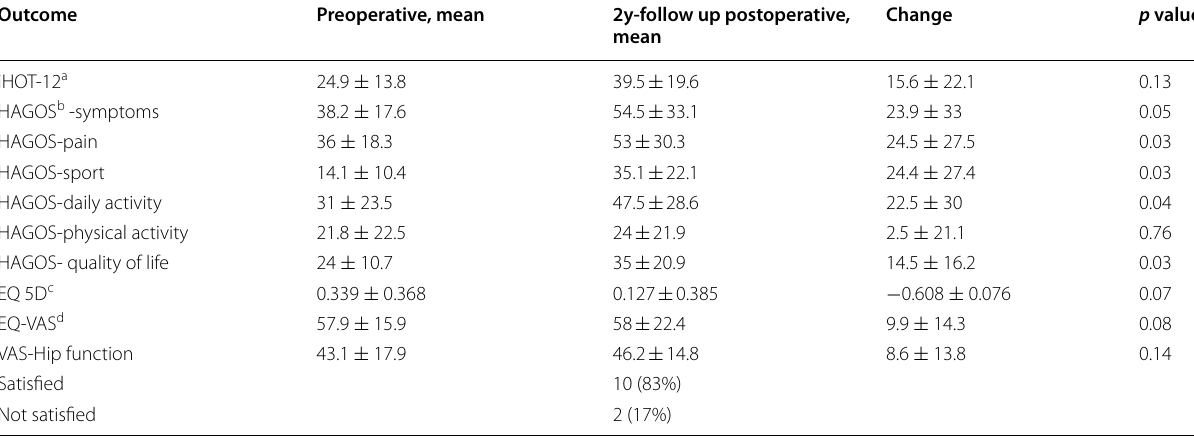
a iHOT-12 International Hip Outcome Tool b HAGOS Copenhagen Hip and Groin Outcome Score c EQ-5D EuroQoL-5 Dimension Questionnaire d VAS visual analogue scale